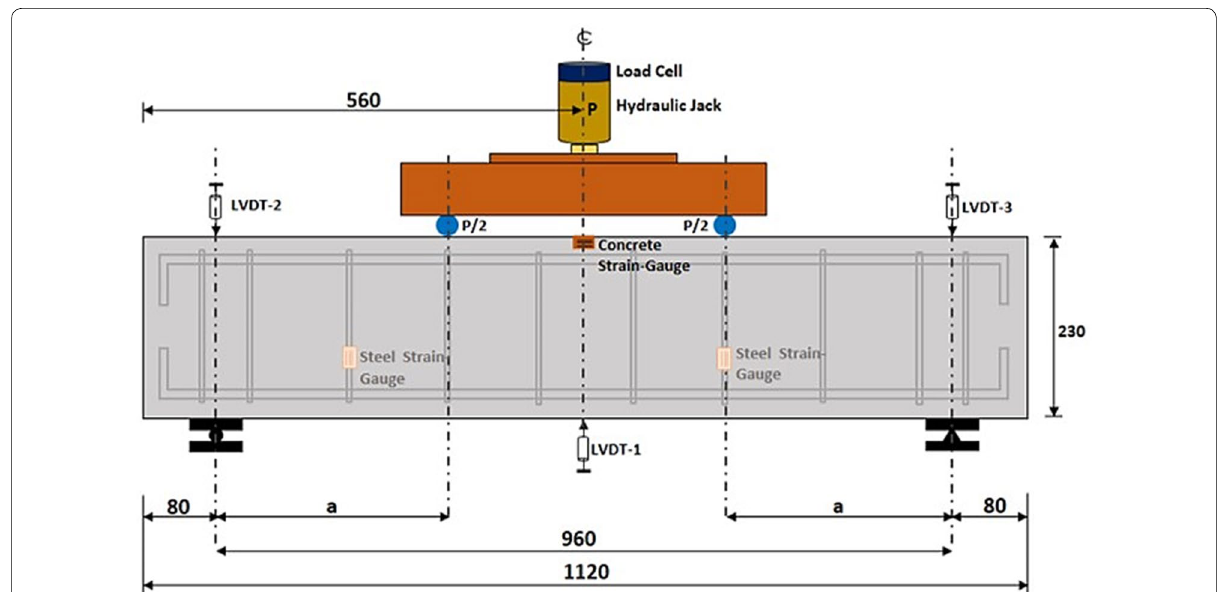
Fig. 7 Schematic representation of beam testing setup (all dimensions in